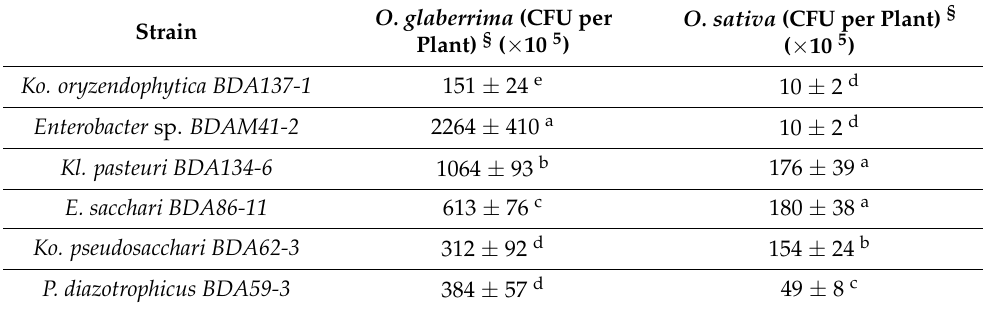
Table 3. Endophytic colonization of O. glaberrima and O. sativa plants by six N-fixing